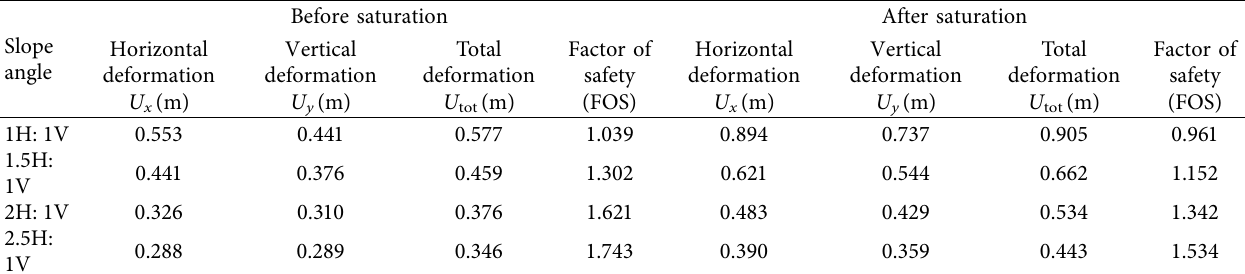
Figure 3: Displacement of CS1 for a slope angle of (1H:1V). Table 2: FOS and slope deformation values for slope-1 by Plaxis 2D before and after saturation.